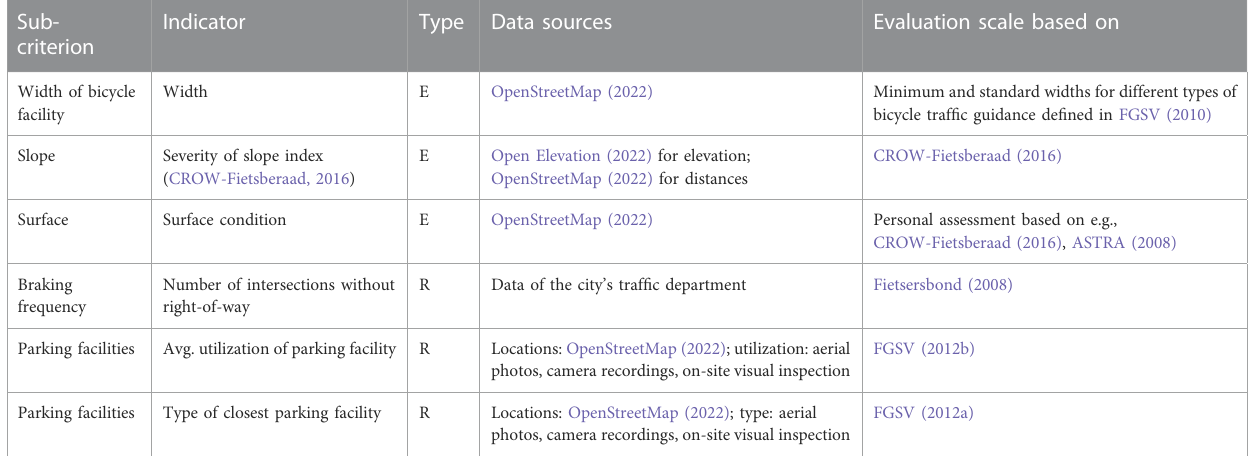
TABLE 3 Comfort: sub-criteria, indicators, type of indicators (E: edge-based, R: route-based, N: network-based), data sources and sources for evaluation scales. Sub-